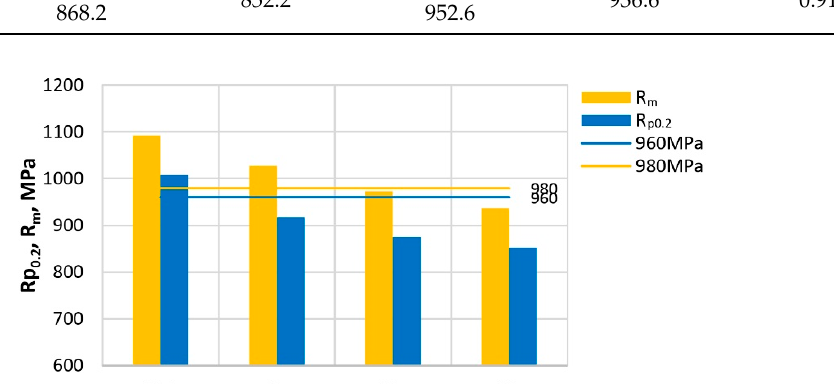
Figure 11. Yield strength and tensile strength for the base material and samples with different cooling times t 8/5 .